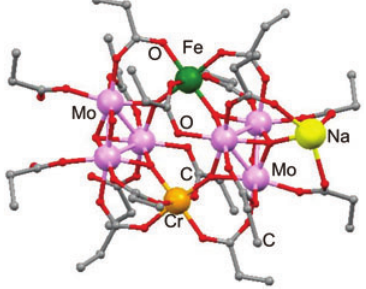
2- anion (M = Fe or Cr) ( Huang O (pr) ] 3 4 8 2